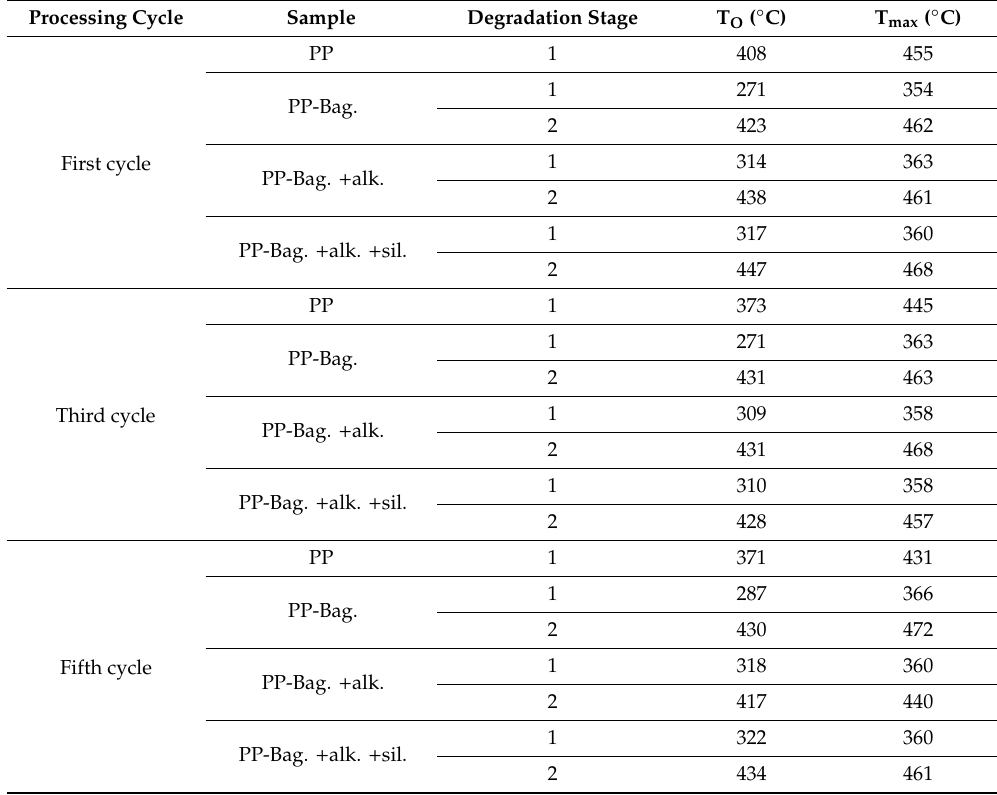
Figure 10. Storage and loss modulus as a frequency function of PP and PP-Bagasse biocomposites: a ) First, b ) Third and c ) Fifth processing cycles.